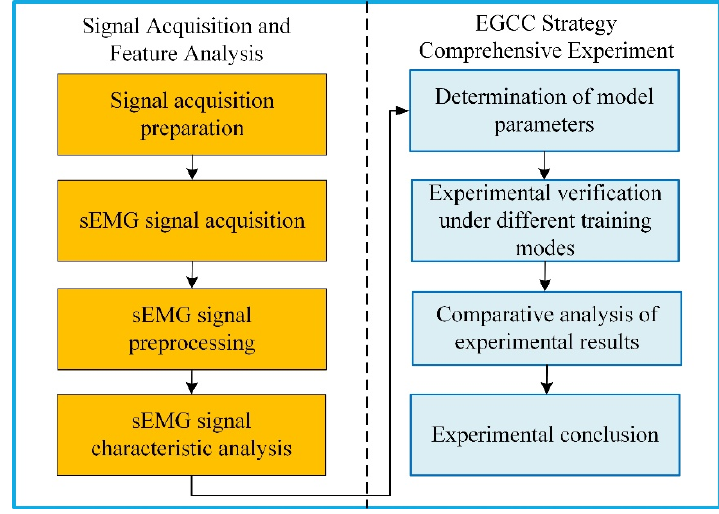
Figure 11. Flowchart of the experimental procedure.